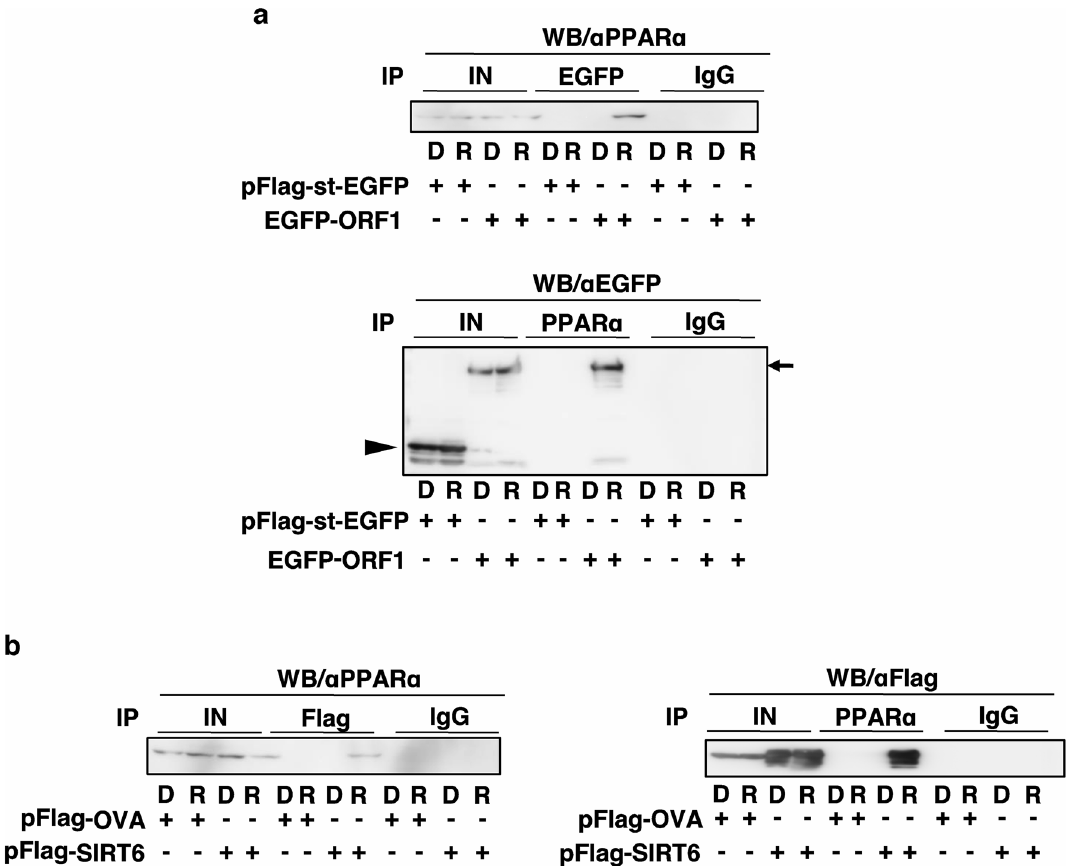
Figure 6. RV promotes the association of PPARα with L1-ORF1. ( a ) PPARα associated with ORF1 by RV. HEK293T cells were transfected with pFlag-st-EGFP or pEGFP-ORF1, and cell extracts were subjected to IP-WB. IP of the left panel was α EGFP → α PPARα. IP of the right panel was α PPARα → α EGFP. Input; IN. 2nd antibody used True blot. Arrow and arrowhead indicate positions of EGFP-ORF1 and Flag-st-EGFP, respectively. ( b ) PPARα associated with SIRT6 by RV. HEK293T cells were transfected with pFlag-OVA or pFlag-SIRT6, and cell extracts were IP-WB. IP of the left panel was α Flag → α PPARα. IP of the right panel was α PPARα → α Flag. The cells were treated with DMSO (0.02%; D) or RV (20 μM;